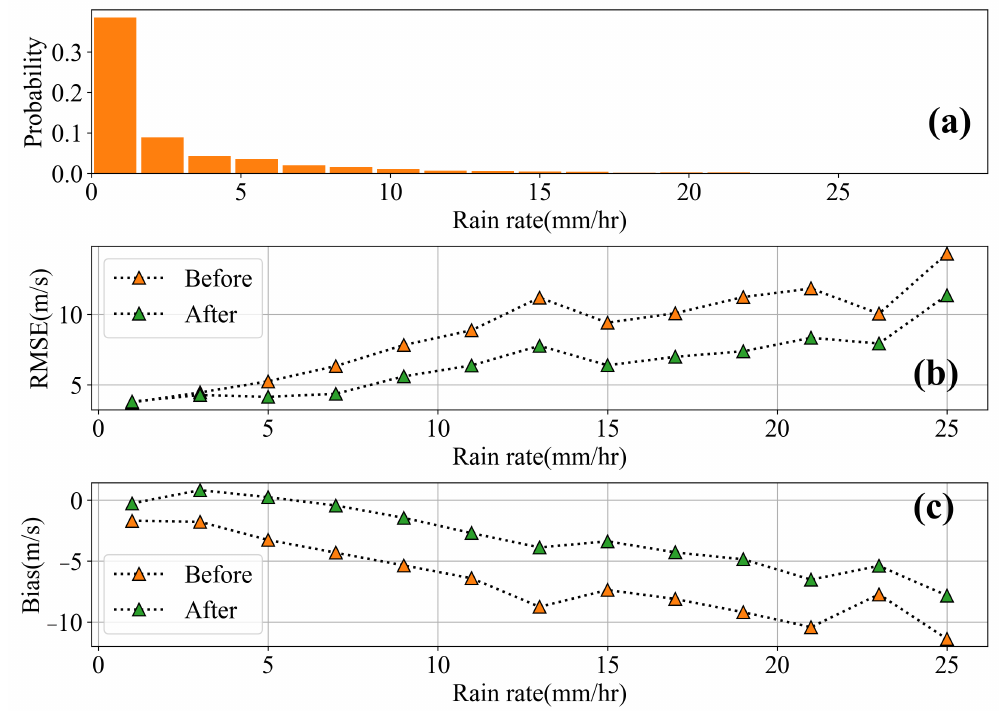
Figure 12. Comparisons before and after revision by the BP-NN algorithm with respect to SFMR. ( a ) Two-dimensional histogram of rain rate in the range 0–30 mm/h. ( b ) RMSE in wind speed before and after revision by the BP-NN algorithm under different rain rate conditions. ( c ) Bias in wind speed before and after revision by the BP-NN algorithm under different rain rate